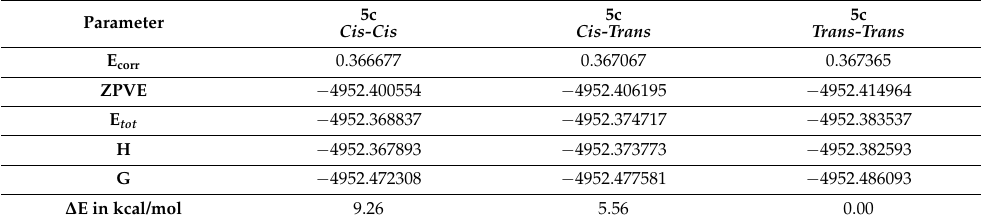
Figure 2. Calculated optimized molecular geometry of the proposed geometrical isomers of the chloro derivative 5c . Table 1. Thermal parameters (hartree/particle) of geometrical isomers of the chloro derivative 5c.